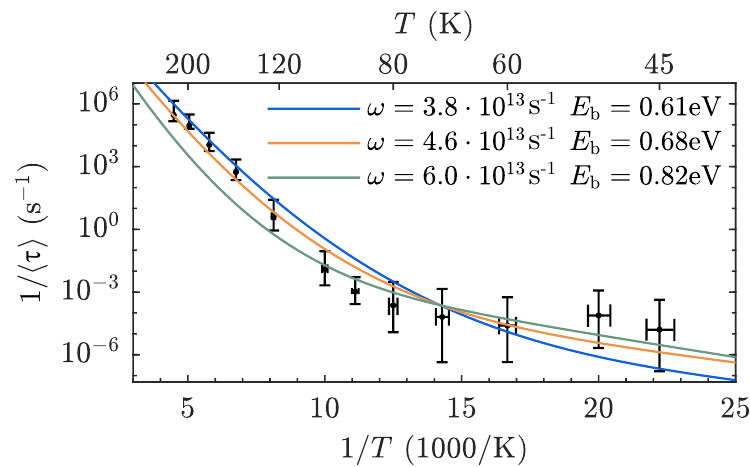
Figure 2. The temperature dependence of the inverse mean decay time of photo-induced absorption in Mg:LN is compared to the small-polaron hopping and recombination